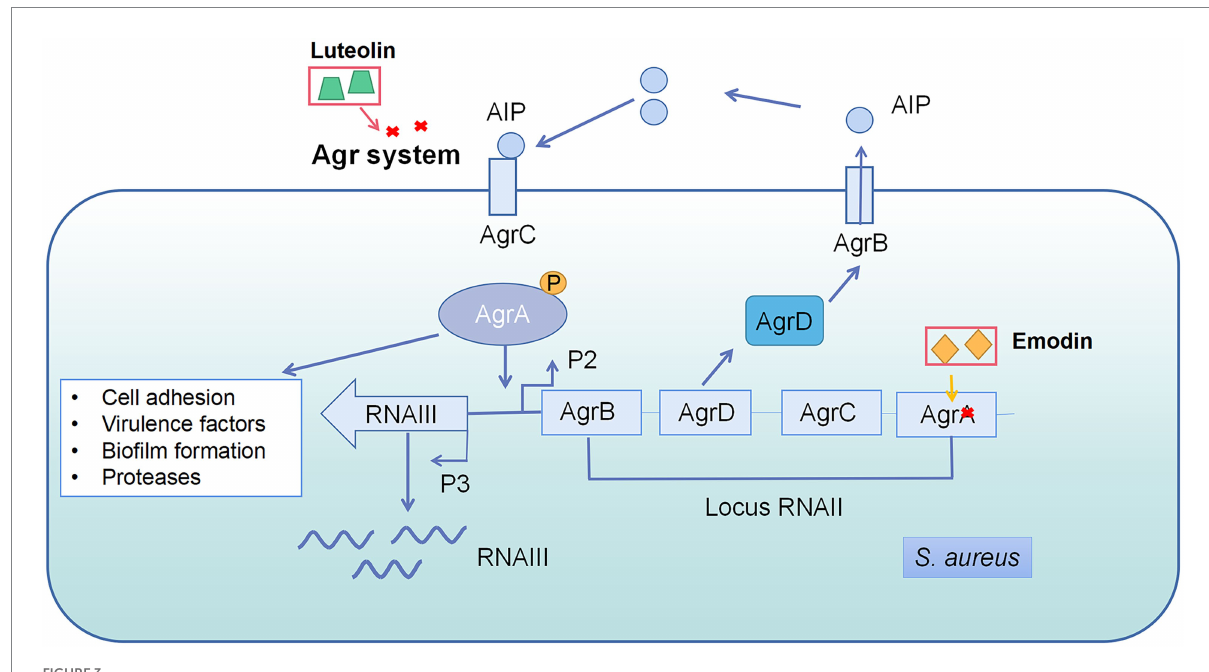
FIGURE 3 Quorum sensing system in Staphylococcus aureus and the interference of natural products on quorum sensing system. AgrD is the precursor of autoinducer peptides (AIP). AIP can be modified by AgrB and secreted into the matrix. AIP secreted by bacteria accumulates in the environment and binds to kinase receptors (AgrC) on the bacterial membrane to transmit signals, activating the related genes’ expression, such as RNAII and RNAIII. RNAIII regulates most QS-related genes, while some genes are controlled by AgrA directly. Emodin inhibited AgrA gene expression and luteolin interfered Agr